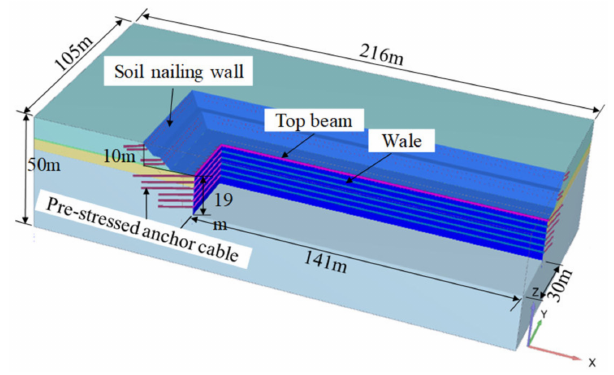
Figure 10. 3D finite element